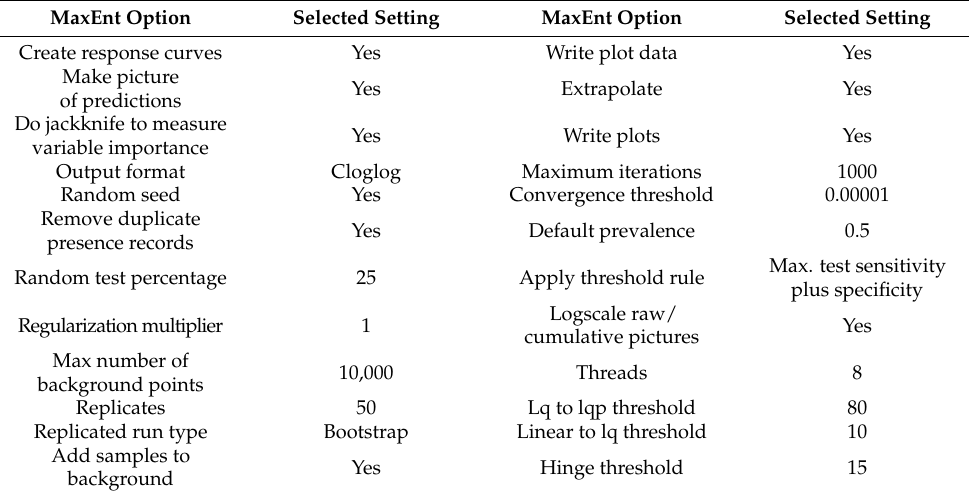
Table 3. Selected MaxEnt